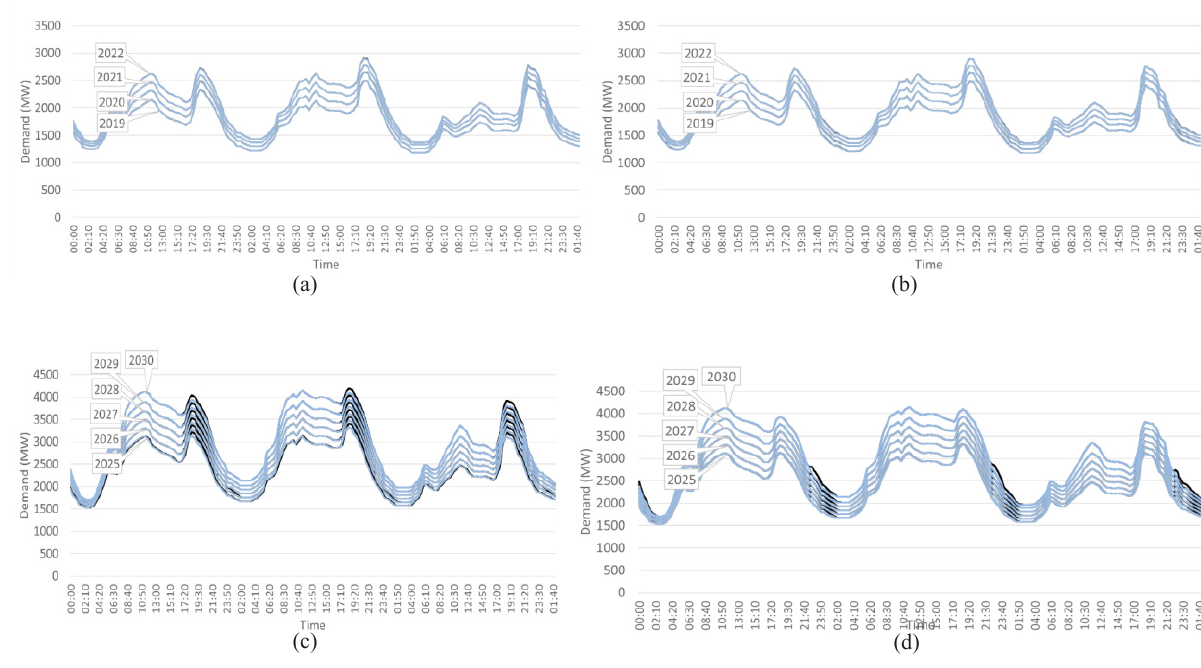
Figure 6: Load curve of Sri Lanka under different EV penetrations and charging profiles. (a) BaU – Dump charging (b) BaU – ToU charging (c) Long term – Dump charging (d) Long term – ToU